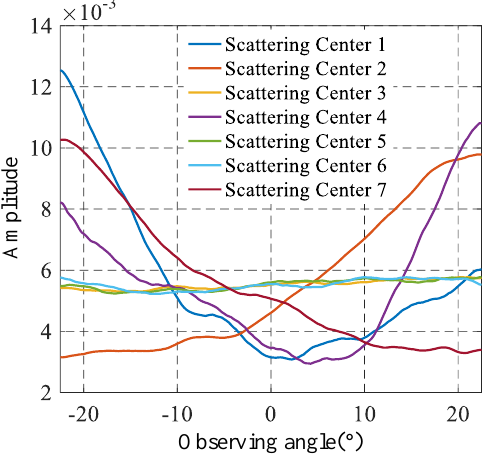
Figure 12. The aspect-dependent amplitudes of the scattering centers.